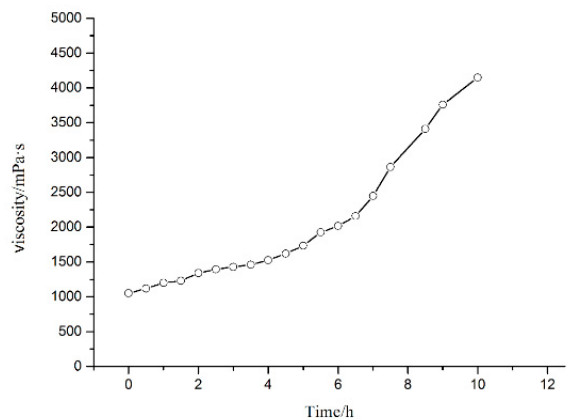
Figure 5. Viscosity–time variation curve of nano-CSR(10 phr)/nano-SiO 2 (2 phr)/epoxy resin system.